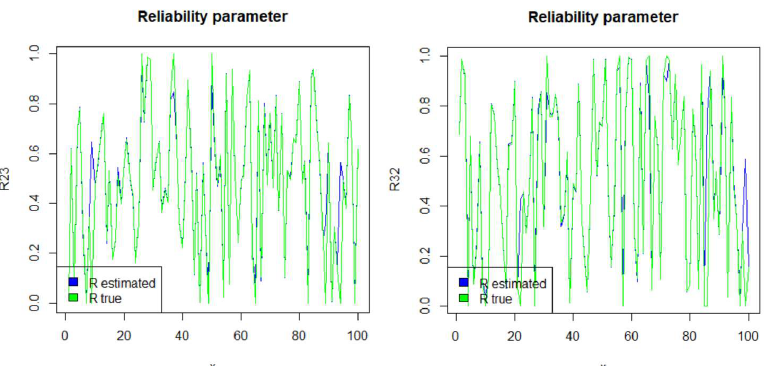
Figure 3. Reliability parameters for the case of uncensored trajectories.